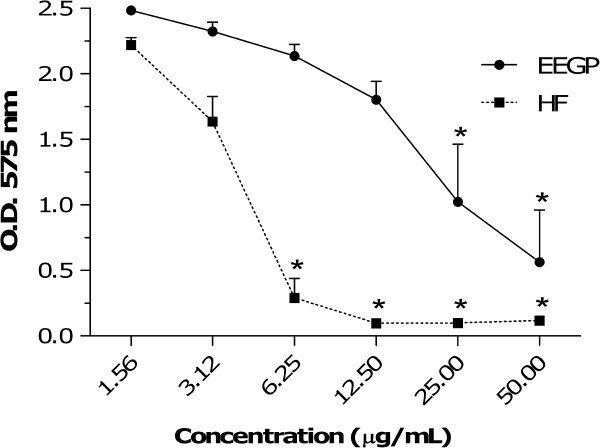
Effect of the ethanolic extract of geopropolis (EEGP) and its hexane fraction (HF) to inhibit the adherence of Streptococcus mutans UA159 growing cells. Each concentration marked with * differs significantly from the vehicle control (p < 0.05, ANOVA, Student-Newman-Keuls).